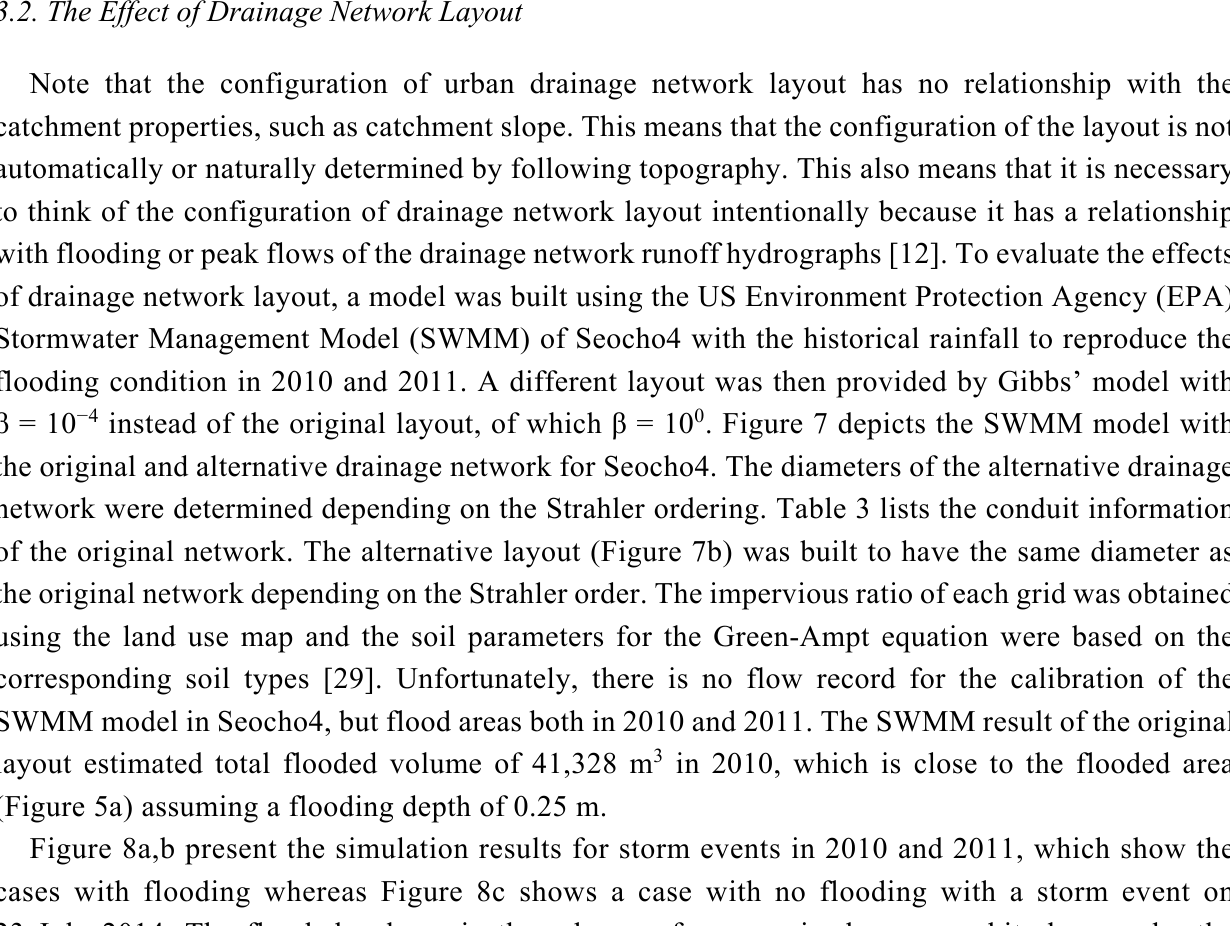
Figure 6. ( a ) Distribution of β for 31 catchments in Seoul; ( b ) the value of β as a function of catchment area; ( c ) perimeter; ( d ) drainage density ( D ); ( e ) conduit slope ( S p ) and ( f ) catchment slope ( S c